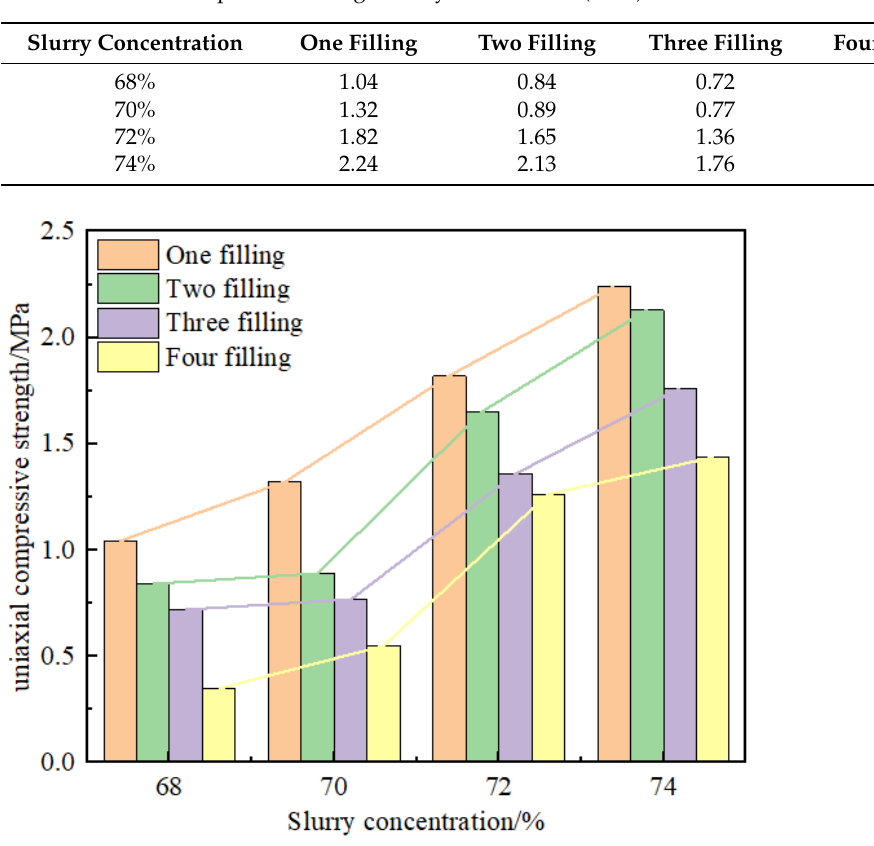
Table 2. Uniaxial compressive strength of layered backfill/(MPa).